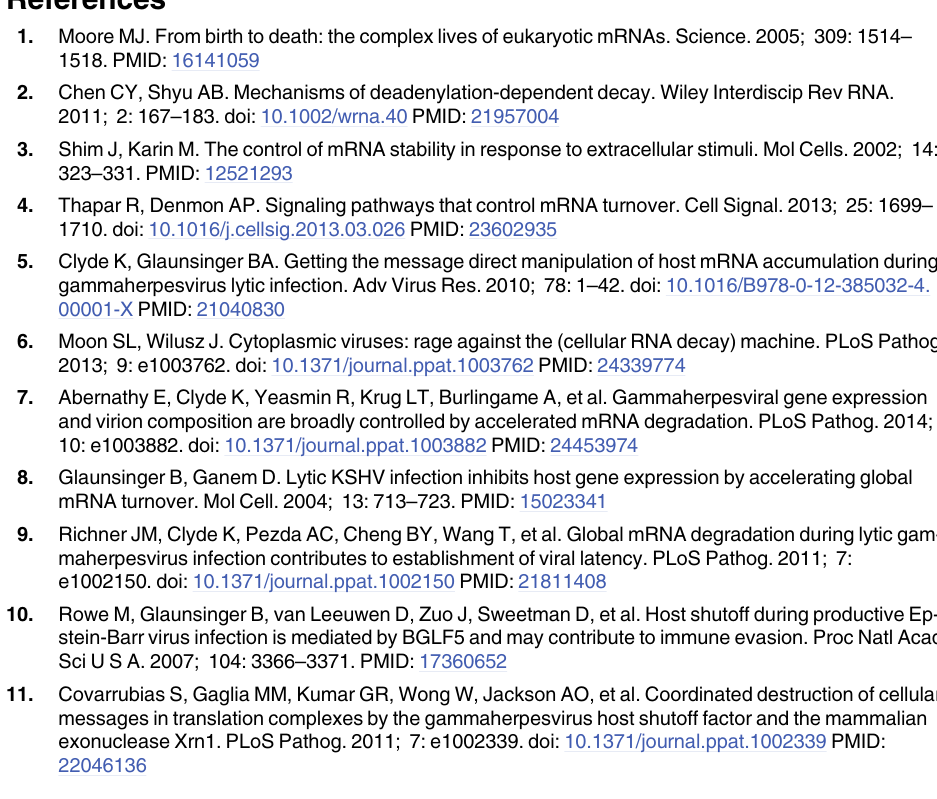
S1 Table. Complete list of proteins identified through mass spectrometry. All proteins iden- tified by MS after Csy4 pull down, including accession number and peptide count. All proteins listed were identified in either TREX-BCBL-1 or 293T and using either IL-6 SRE or a IL-6 nt 251 – 450. S2 Table. Go term analysis of MS results shows 7 clusters. High confidence SRE interacting proteins were subjected to GO term analysis using DAVID bioinformatics database. This table lists the 7 clusters, the GO terms and the proteins involved in the clusters. S3 Table. siRNA target sequences. S4 Table. Sequences of primers used for